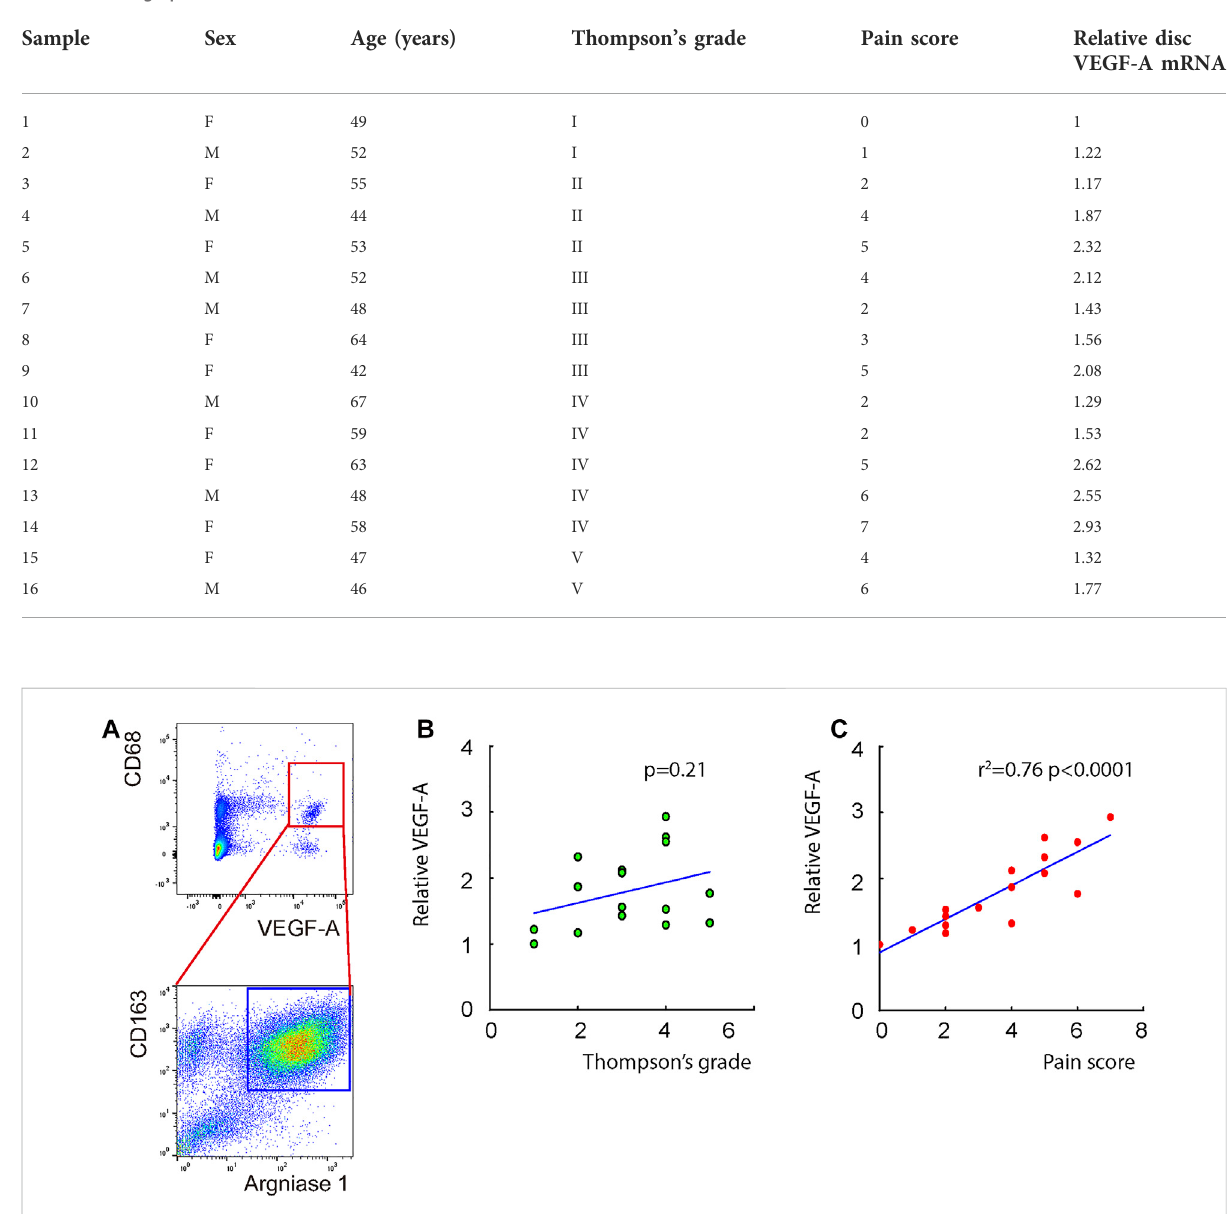
FIGURE 1 Detection of a VEGF-A-expressing disc macrophage subtype in LDD patients. Disc specimens were analyzed from 16 participants who had different Thompson classi fi cation of the degeneration level and pain score. (A) The disc specimens were digested into a single cell fraction and subjectedto fl uorescence activatedcellsorting(FACS)forCD68 andVEGF-A.The VEGF+CD68 + cellswerefurtheranalyzedforCD163andArginase 1,shownbyarepresentative fl owchart. (B – C) TheVEGF-AtranscriptsintheseVEGF-A+macrophages werequanti fi edinall16 specimens. The correlation between VEGF-A transcripts andThompsonclassi fi cation ofthedegenerationlevel [ (B) , p =0.21] orpain score[ (C) , r 2 =0.75, p < 0.0001] was